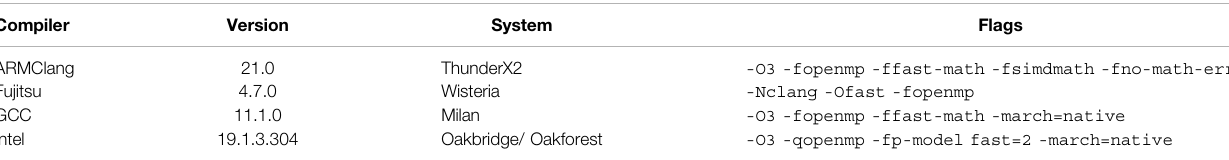
TABLE 3 | Compiler fl ags used to enable auto-vectorisation.